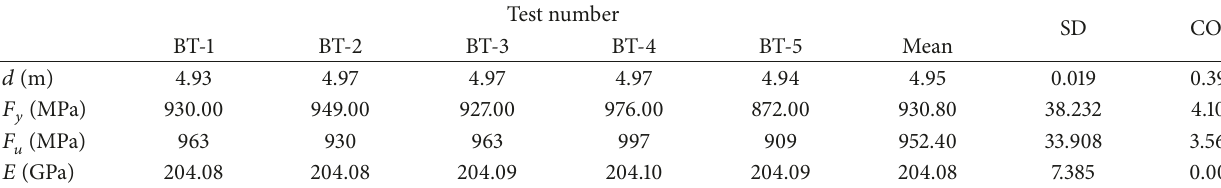
Table 2: Material properties of